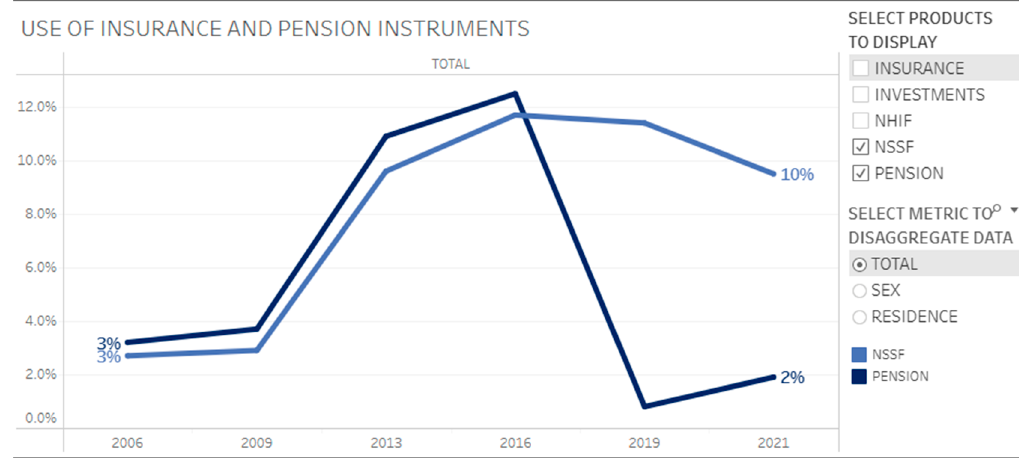
Figure A1. NSSF and other pension uptake over time. Source: FinAccess Kenya (2022).